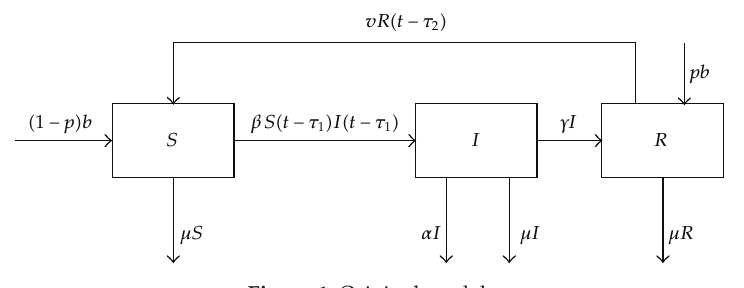
Figure 1: Original